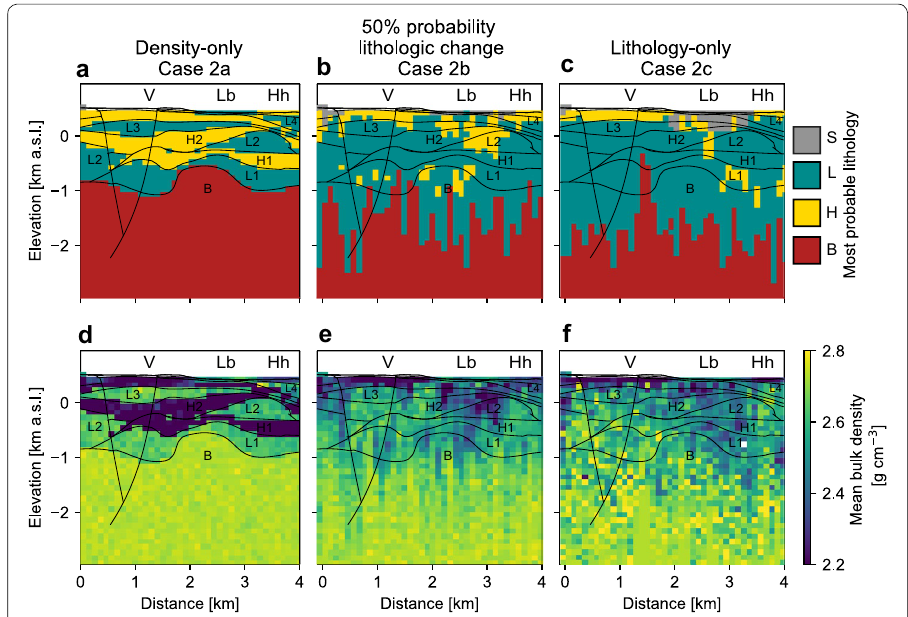
Fig. 9 Posterior results for inversion runs without commonality of shape ratio constraints and variable probability of lithologic changes (Case 2). Posterior results for a – c . Most probable lithology and ( d – f ) mean bulk density for inversion runs with variable probability of the inversion process proposing lithologic changes: ( a , d ) 0% probability of lithologic changes (density-only inversion, Case 2a), ( b , e ) 50% probability of lithologic changes (Case 2b) ( c , f 100% probability of lithologic change (Case